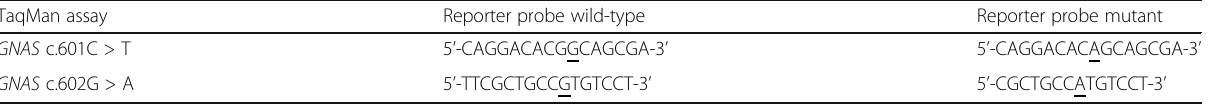
Underscored nucleotides are hot-spot mutation